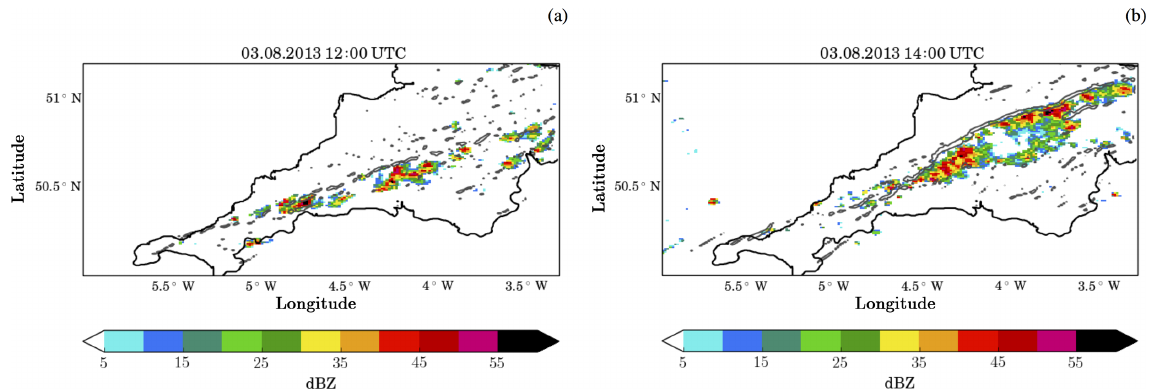
Figure 1. Column maximum radar reflectivity (shading) over the COPE domain at (a) 12:00UTC and (b) 14:00UTC from the model simulation with passive aerosol and the standard-aerosol profile. The grey contour lines indicate convergence of 2 × 10 − 6 s − 1 at 250 m above ground.